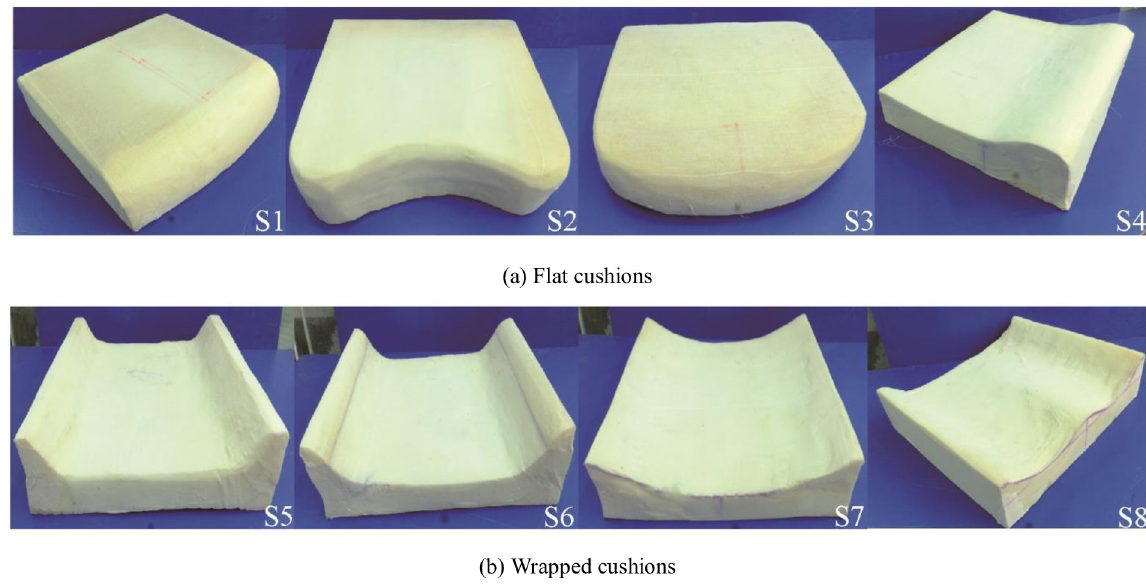
Fig 6. Eight kinds of contoured cushion production molding. (a) Flat cushions and (b) Wrapped cushions.